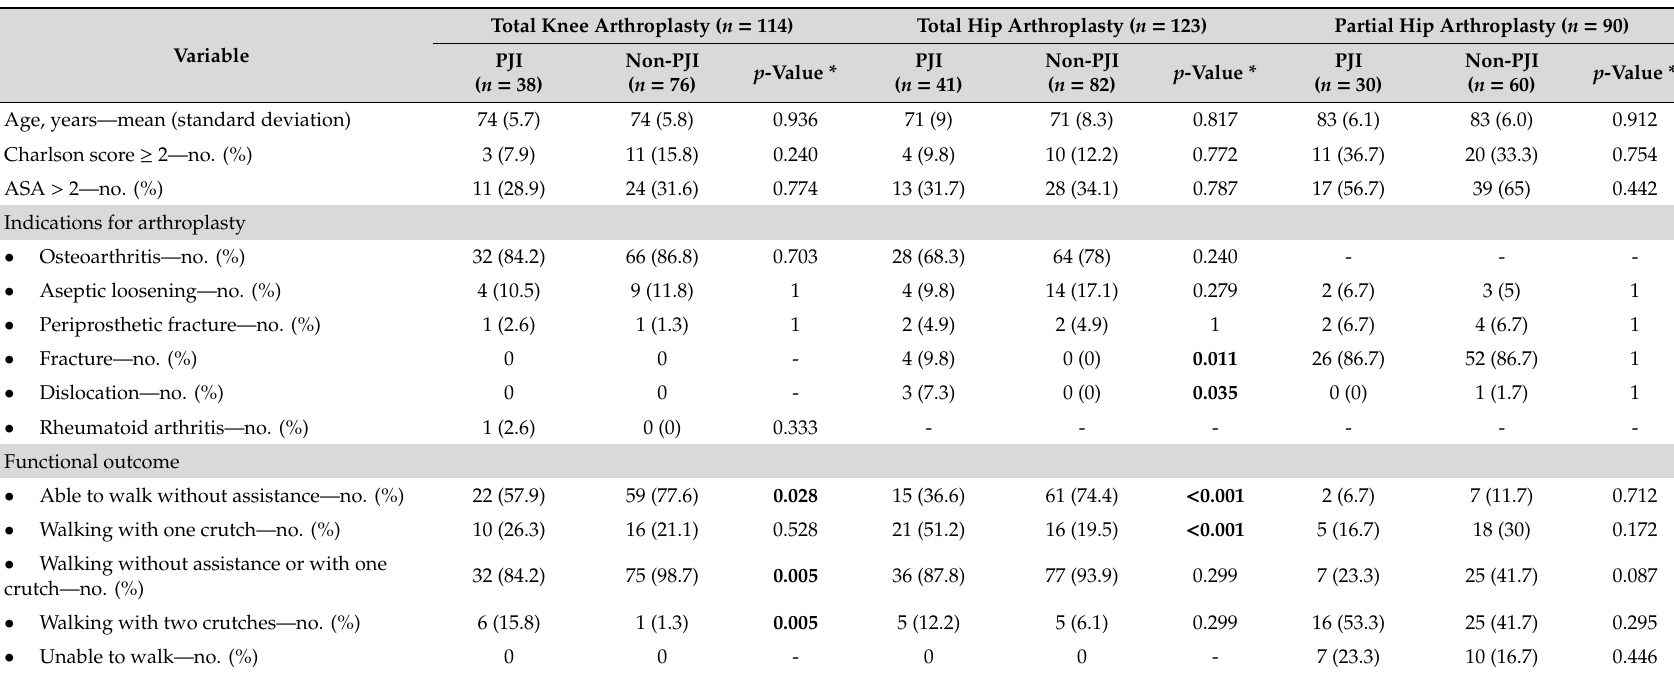
Table 2. Characteristics of 327 patients with hip and knee arthroplasties, with and without prosthetic joint infection, matched 1:2 by gender, age ± 5 years, type of prosthesis, primary or revision arthroplasty and year of index